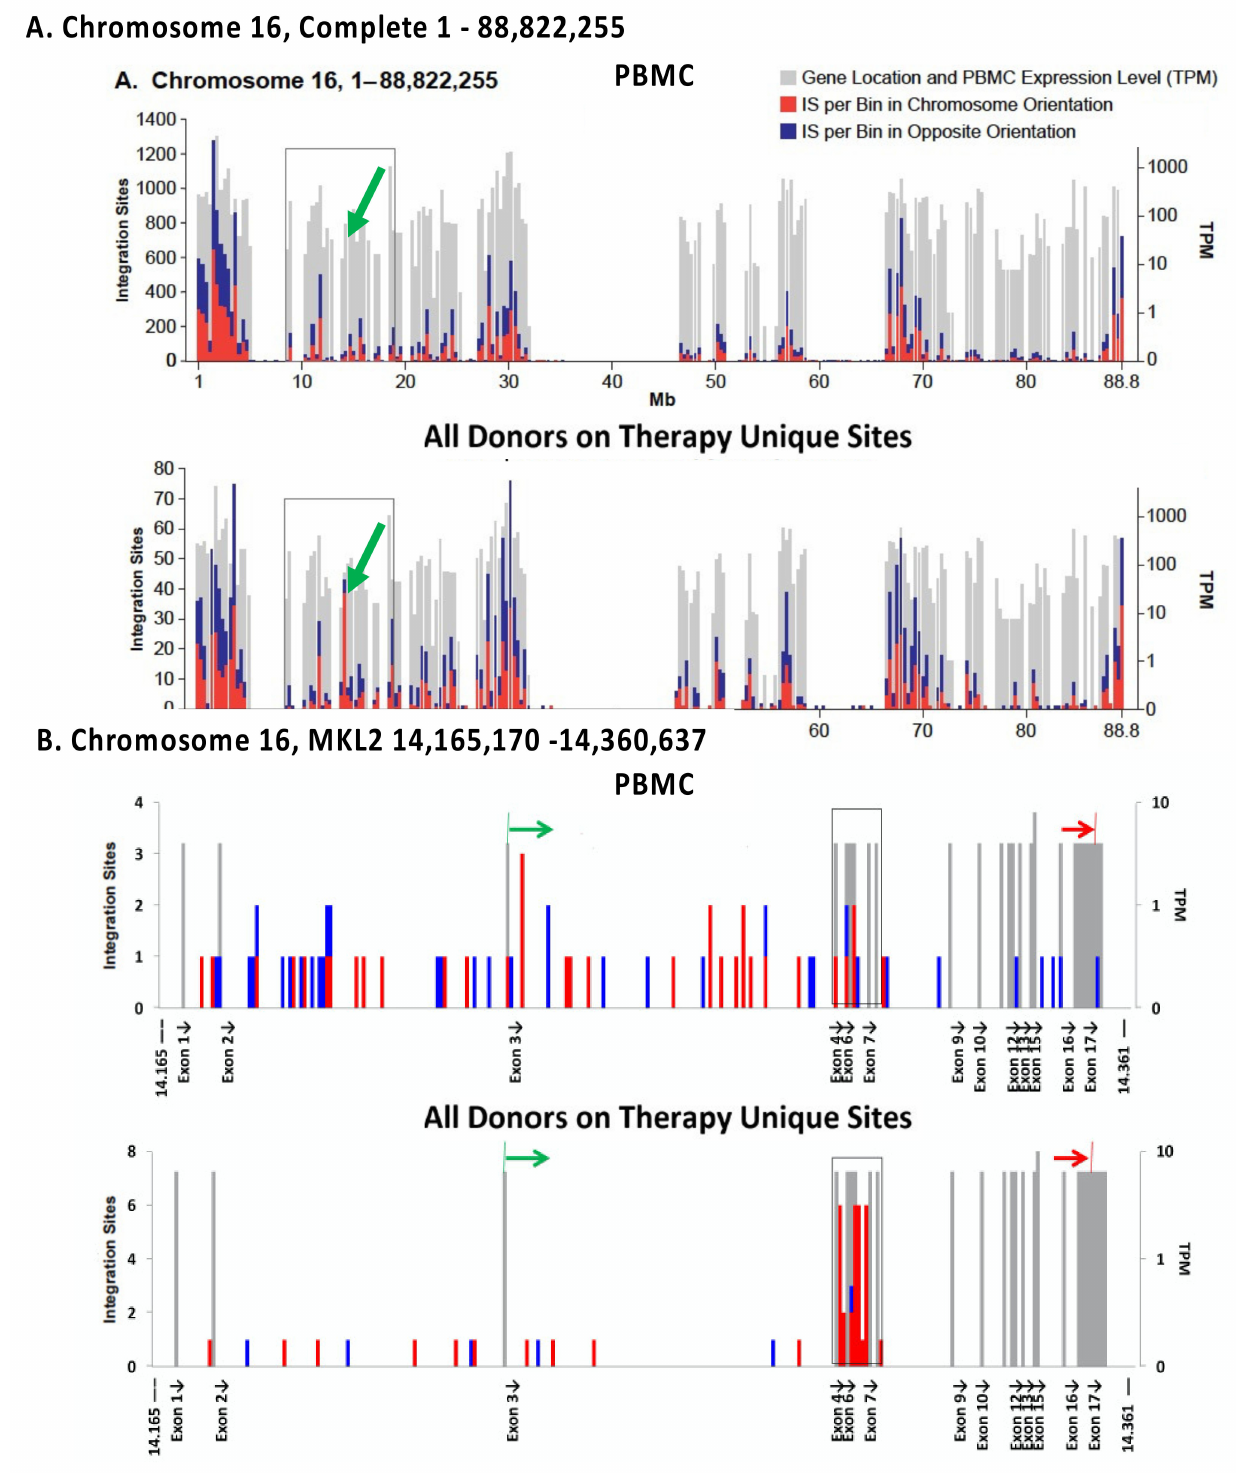
Figure 5. Integration site distribution in vivo and in vitro. Chromosome 16 was divided into 250 bins and the level of RNA, as measured by RNA-seq analysis of PHA-activated PBMCs, in each bin (gray bars) and the integration site distribution (red—the provirus is in the same orientation as the numbering of the chromosome; blue—opposite orientation, relative to the numbering of the chromosome) are shown for each bin. In both panels ( A , B ), the diagram at the top shows data obtained from PBMCs infected in vitro; the diagram at the bottom shows unique sites from pooled in vivo data. ( A ) Complete chromosome 16. The long green arrows indicate the location of the MKL2 gene. ( B ) MKL2 gene. Black arrows indicate exons; short green and red arrows, translation start and stop sites, respectively. Reprinted from